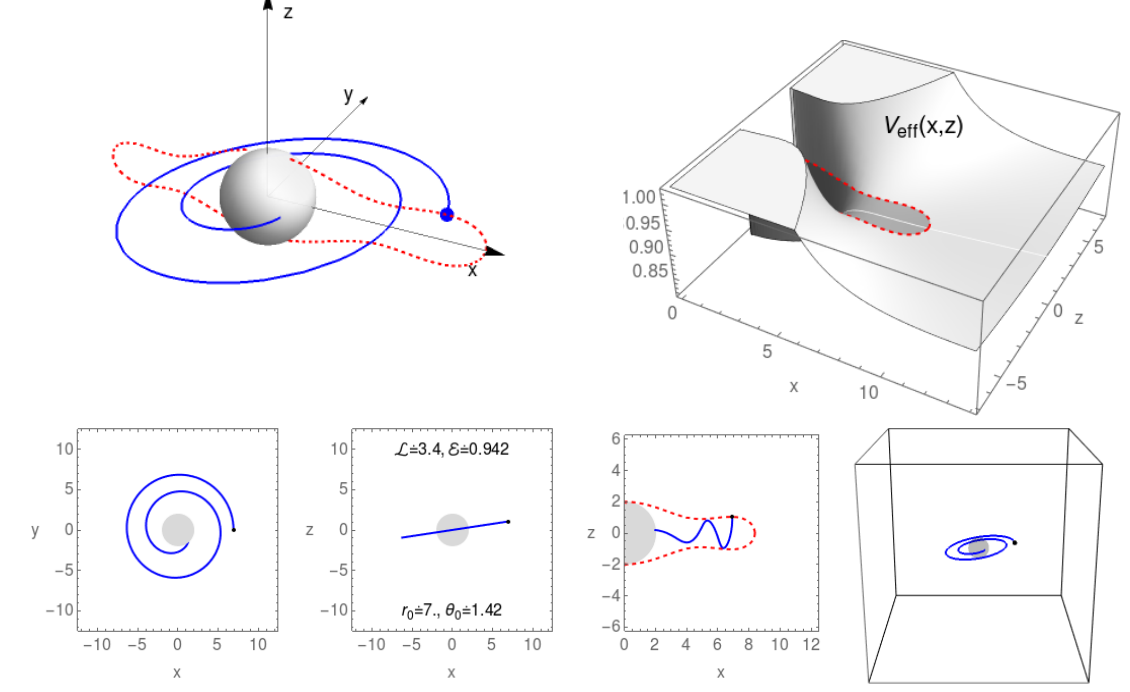
Figure 3. Charged particle captured by BH with magnetic filed, for detailed description see Figure 2.